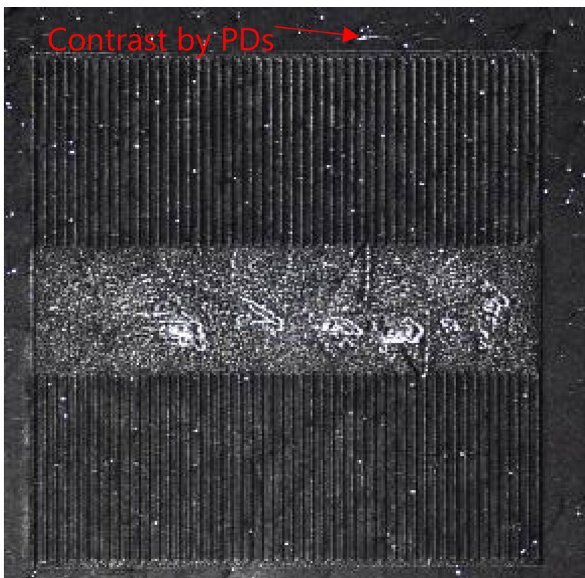
Figure 4. X-ray topographic image of the PiN diode shown in Fig. 3a.